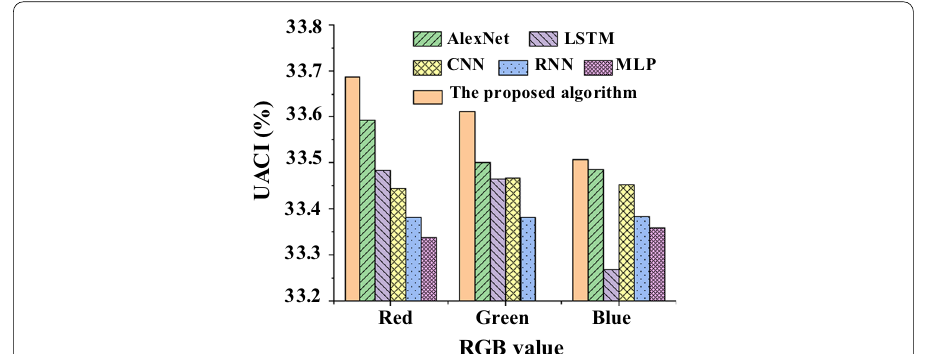
Fig. 10 The influence of different algorithms on NPCR (%) of pixel value at (0, 0)